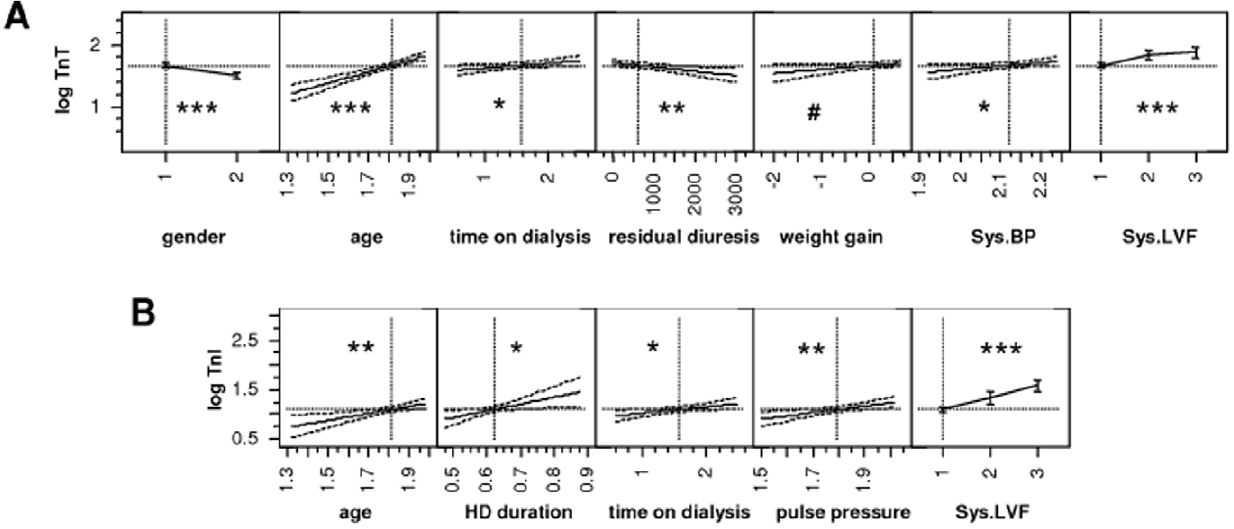
Figure 2. Plot showing the influence of single predictors in the multivariate model for troponin T (A) and troponin I (B). # p , 0.10, * p , 0.05, ** p , 0.01, *** p , 0.001.